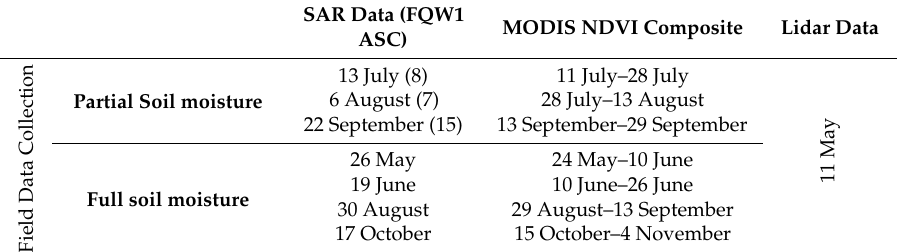
Table 1. List of remote sensing image acquisition dates. Measurements of field data coincide with SAR data acquisition dates. For full soil moisture acquisitions, n = 32. For partial acquisitions, the sample size on that date is in brackets in the SAR Data